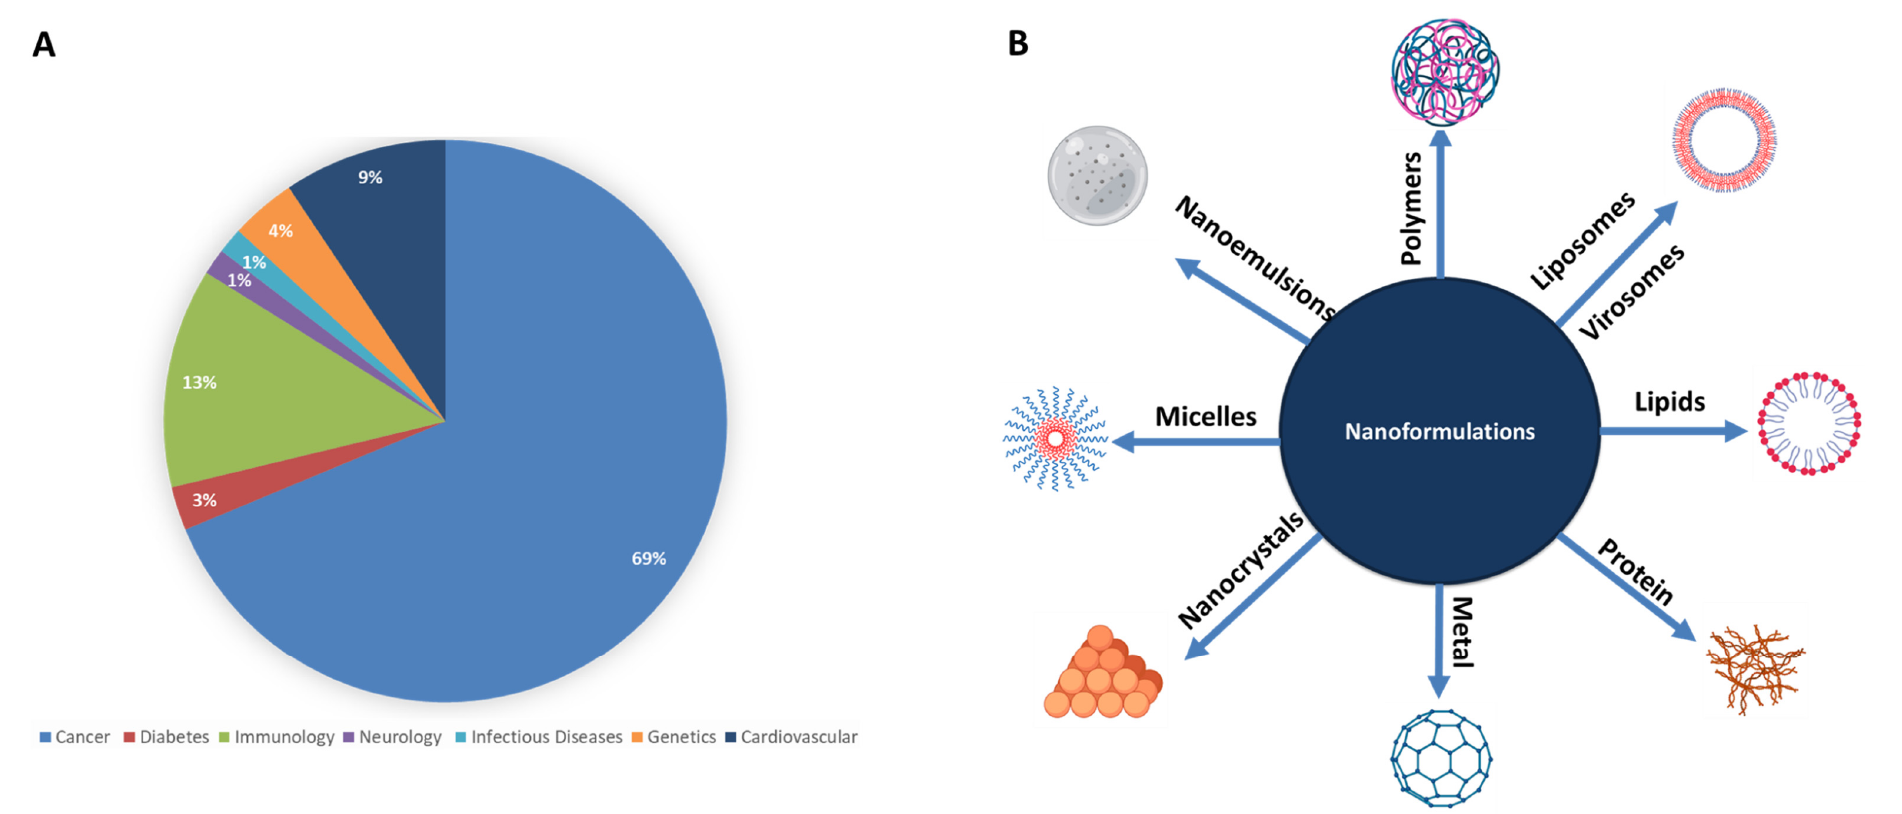
Figure 1. ( A ) Percentage of nanoformulations application in each medical field, and ( B ) different nanoformulations currently in use in the medical field.